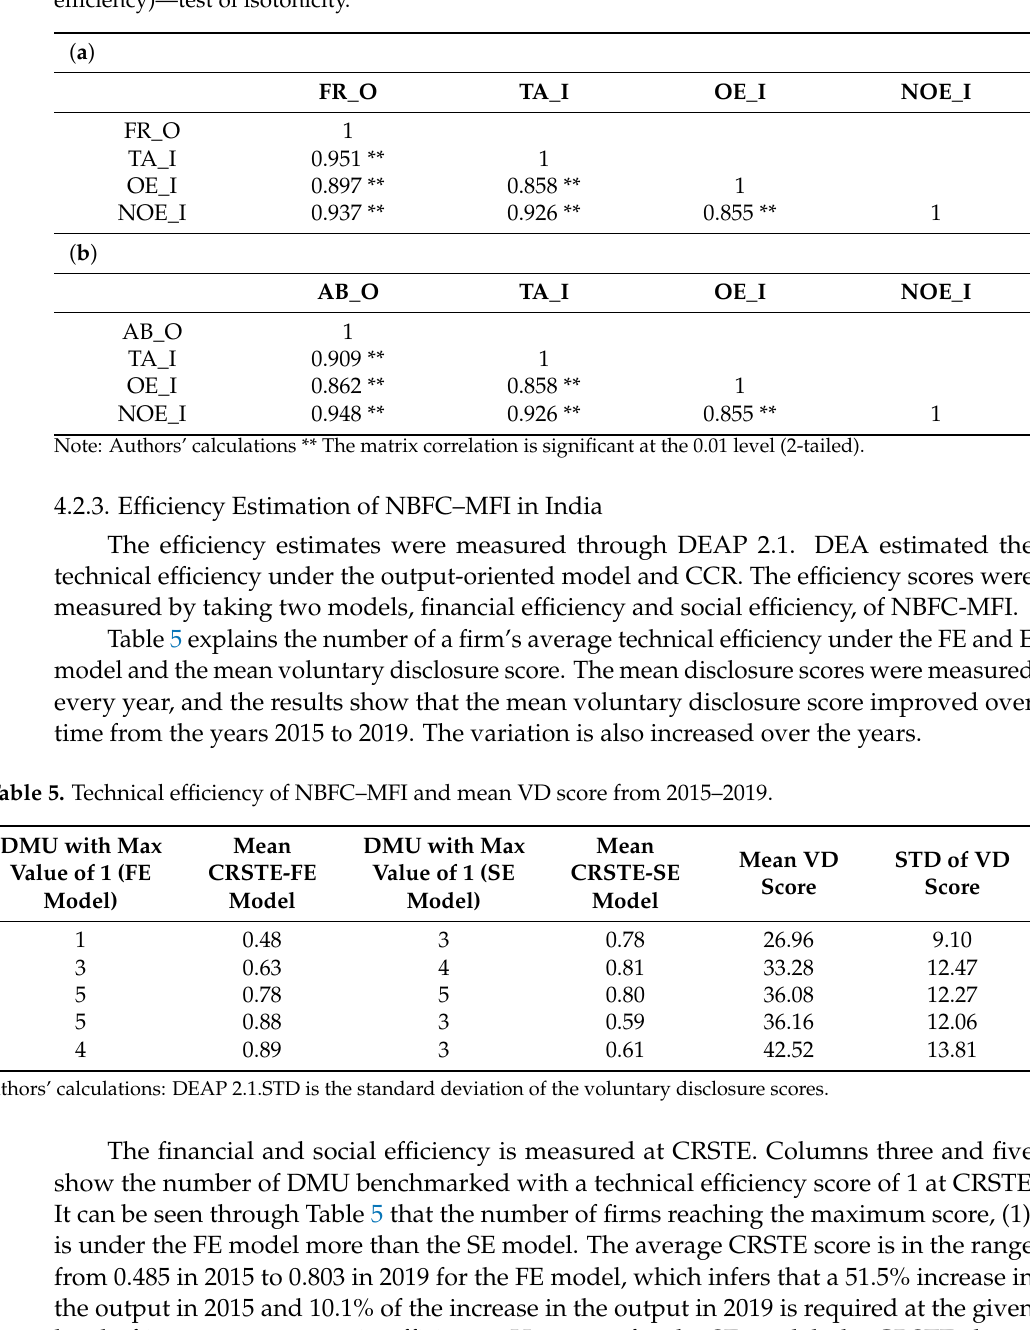
Table 4. ( a ) Correlation matrix (financial efficiency)—test of isotonicity; ( b ) Correlation matrix (social efficiency)—test of isotonicity.